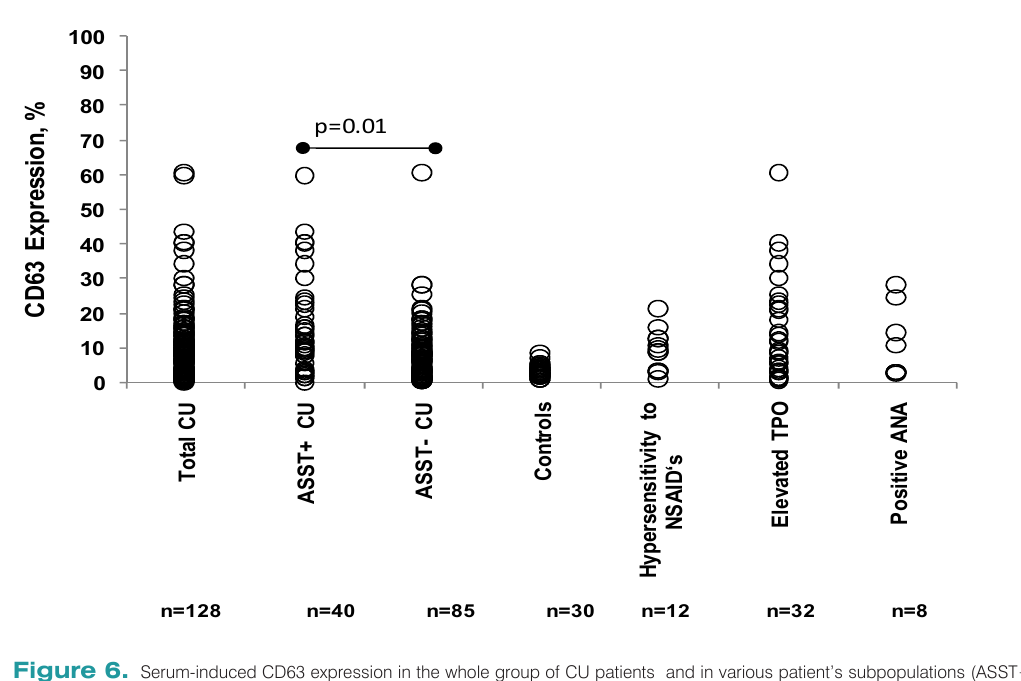
Figure 6. Serum-induced CD63 expression in the whole group of CU patients and in various patient’s subpopulations (ASST+ and ASST- CU patients, CU patients with other autoreactivity markers and controls). A significant difference in CD63 expression was found only between ASST+ and ASST- patients, but not between other groups of patients with CU.